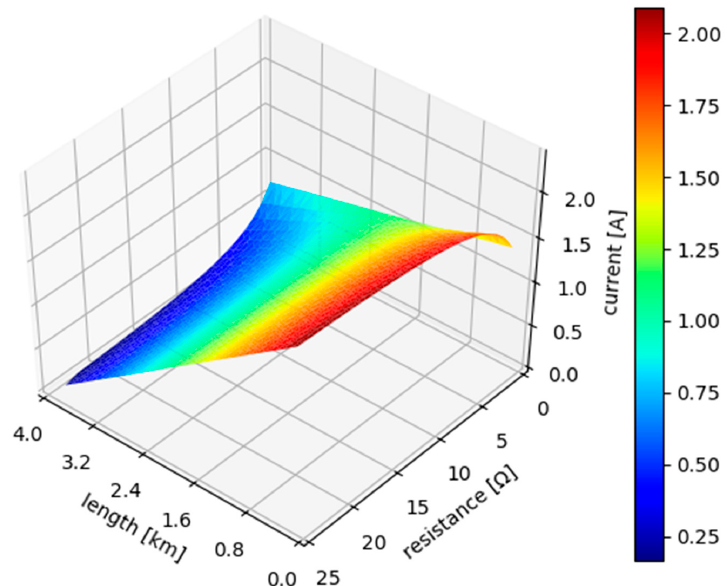
Figure 13. No-load screen current measured at the load side; formation presented in Figure 2c.